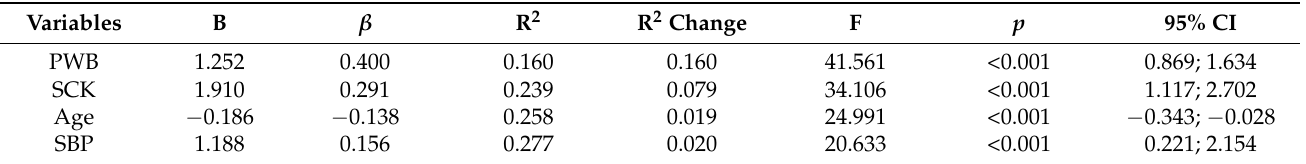
Table 3. Stepwise regression analysis results of the disease self-management in patients with hyper- tensive